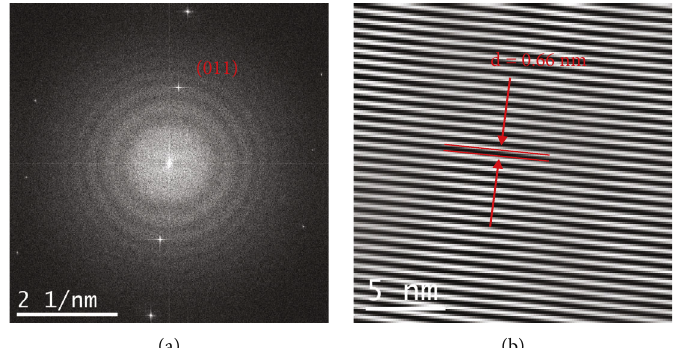
Figure 10: (a) SAED pattern of quartz obtained from the area enclosed within the red square in Figure 6(a). (b) HRTEM image of quartz obtained from the colored square in Figure 6(a).